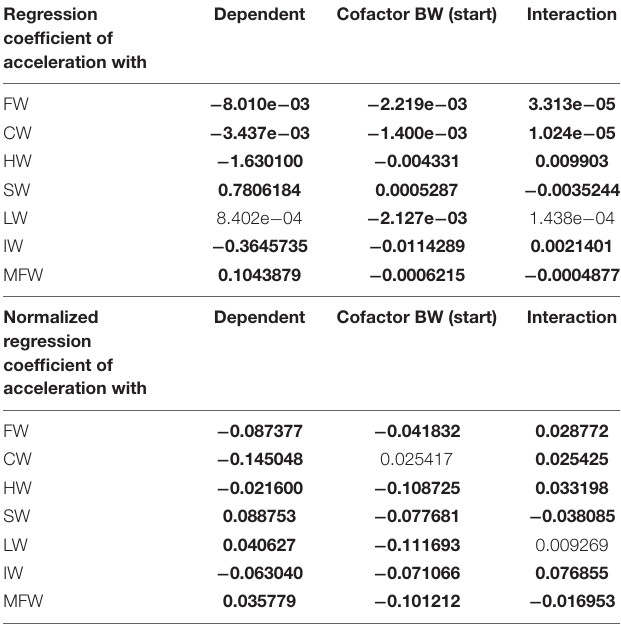
TABLE 2 | Regression coefficients and normalized regression coefficients of acceleration vs. filet weight (FW); carcass weight (CW); heart weight (HW); spleen weight (SW); liver weight (LW); intestine weight (IW); and mesenteric fat weight (MFW), with body weight (BW) as cofactor and providing the interaction effect between cofactor and dependent